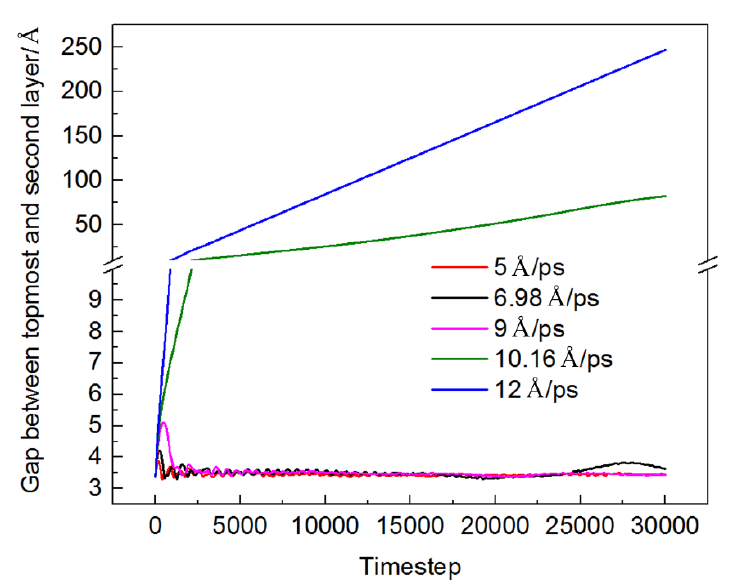
Figure 7. Variation of distance between the topmost and second layers of graphene versus timestep.